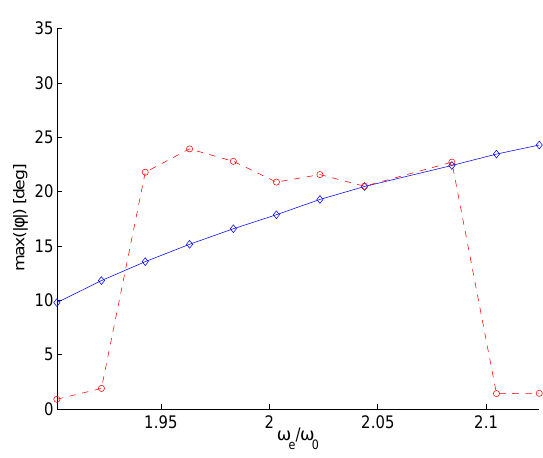
Figure 22: Exp. 1193. Exp. dashed red, sim. solid blue.